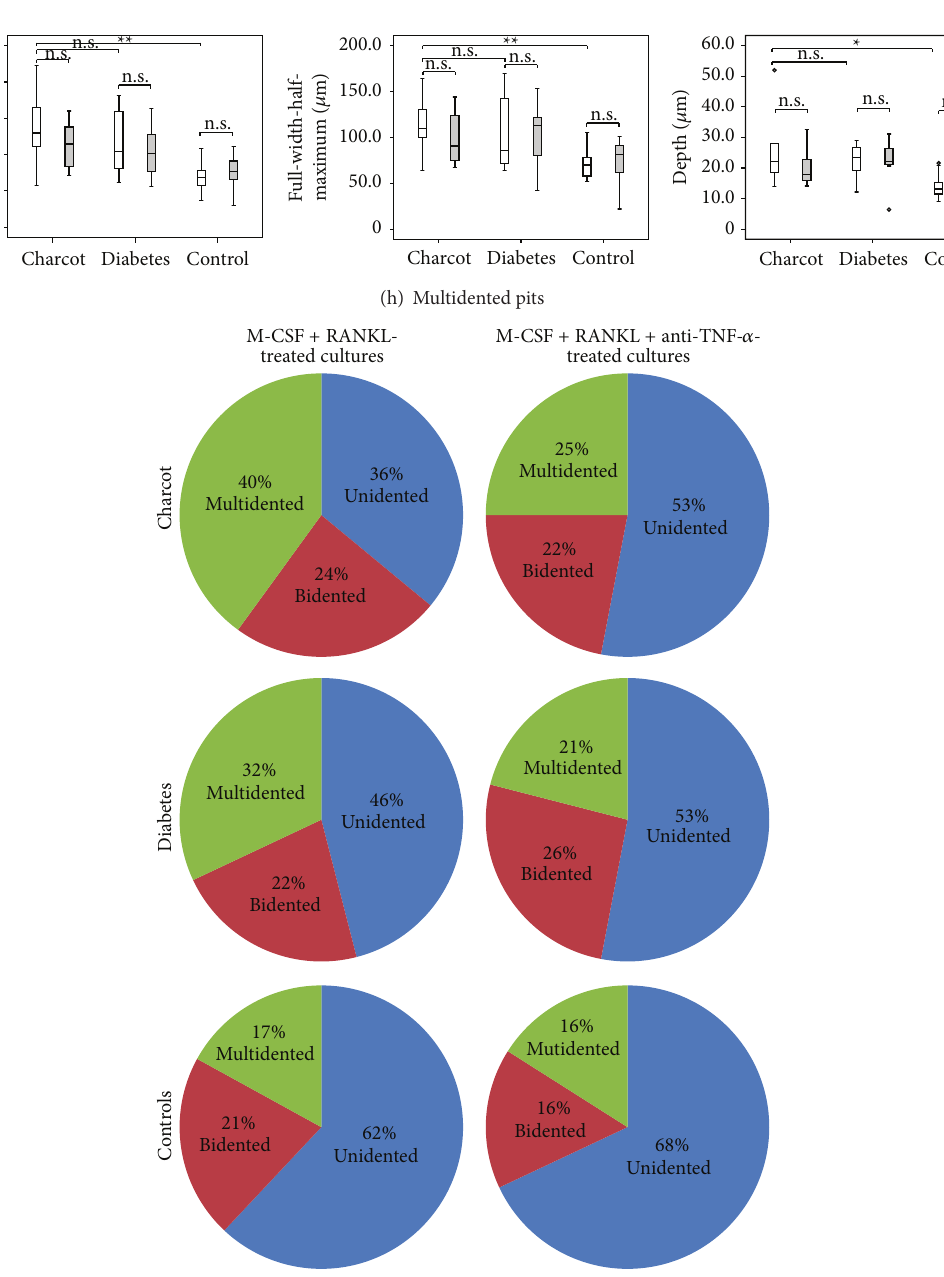
Figure 2: Surface profilometry in Charcot patients, diabetic patients, and healthy control subjects in M-CSF + RANKL-treated cultures and in M-CSF+RANKL+anti-TNF- 𝛼 -treatedcultures.RepresentativeerosionprofilesofresorbedbonediscsinCharcotpatient(blueline),diabetic patient (red line), and healthy control subject (green line) after surface profilometry in M-CSF + RANKL-treated cultures (a) and in M-CSF + RANKL + anti-TNF- 𝛼 -treated cultures (b). Representative erosion profiles of resorbed bone discs in M-CSF + RANKL-treated cultures (blue line) and M-CSF + RANKL + anti-TNF- 𝛼 -treated cultures (red line) in Charcot patient (c), diabetic patient (d), and healthy control subject (e). The marked difference of the erosion profile in a Charcot patient compared with diabetic patient and healthy control in MCSF + RANKL-treated cultures (a) was reversed after the addition of anti-TNF- 𝛼 (b). Pits appeared significantly smaller in M-CSF + RANKL + anti-TNF- 𝛼 -treated cultures compared with MCSF + RANKL-treated cultures in Charcot patients (c) but remained unchanged in diabetic patients (d) and in healthy controls (e). Comparison of pit measurements (width, FWHM, and depth) between M-CSF + RANKL-treated cultures (white bars) and M-CSF + RANKL + anti-TNF- 𝛼 -treated cultures (grey bars); unidented pits (f), bidented pits (g), and multidented pits (h). Significance assessed by Mann-Whitney 𝑈 test, levels of significance are demonstrated on the graphs; ∗ 𝑝 < 0.05 ; ∗∗ 𝑝 < 0.01 ; ns = nonsignificant ( 𝑝 > 0.05 ). Distribution of pits (%) according to their shape in M-CSF + RANKL and M-CSF + RANKL + anti-TNF- 𝛼 -treated cultures in Charcot patients, diabetic patients, and healthy control subjects (i). In M-CSF + RANKL-treated cultures, there was a significant reduction in the percentage of unidented ( 𝑝 < 0.05 ) and a significant increase in the percentage of multidented pits ( 𝑝 < 0.05 ) in Charcot patients compared with diabetic patients and healthy controls. The addition of anti-TNF- 𝛼 treatment led to a significant difference in the pit distribution only in Charcot patients characterised by a significant increase in the percentage of unidented pits ( 𝑝 < 0.05 ) and significant decrease in the percentage of multidented pits ( 𝑝 < 0.05 ). No differences in the pit distribution were noted in diabetic patients and in healthy control